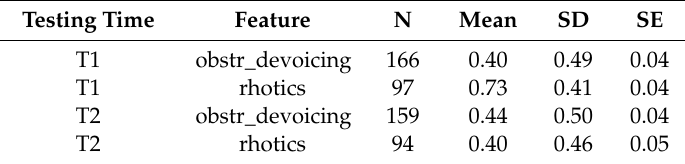
Table 15. Mean Accuracy with respect to the Time*Feature interaction for L3